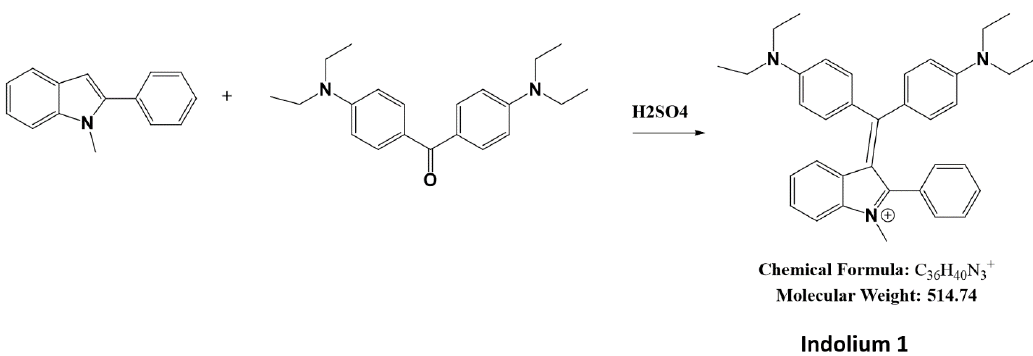
Figure 1. Synthesis of Indolium 1.